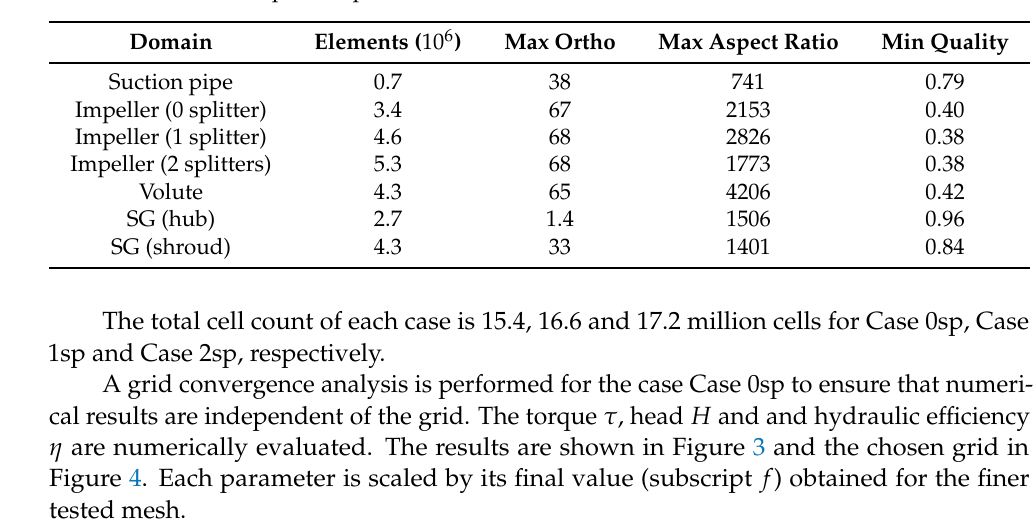
Table 2. Mesh metrics per computational domain.